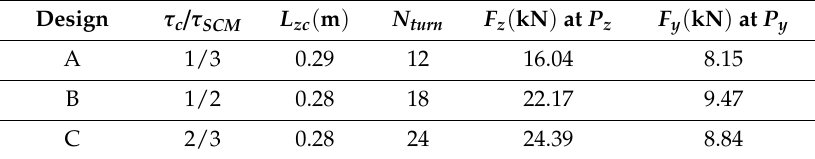
Figure 16. 3D CAD models of the selected levitation coils: ( a ) Design A with τ c = ( 1/3 ) τ SCM , ( b ) Design B with τ c = ( 1/2 ) τ SCM , and ( c ) Design C with τ c = ( 2/3 ) τ SCM . Table 2. The three selected designs to be further analyzed and